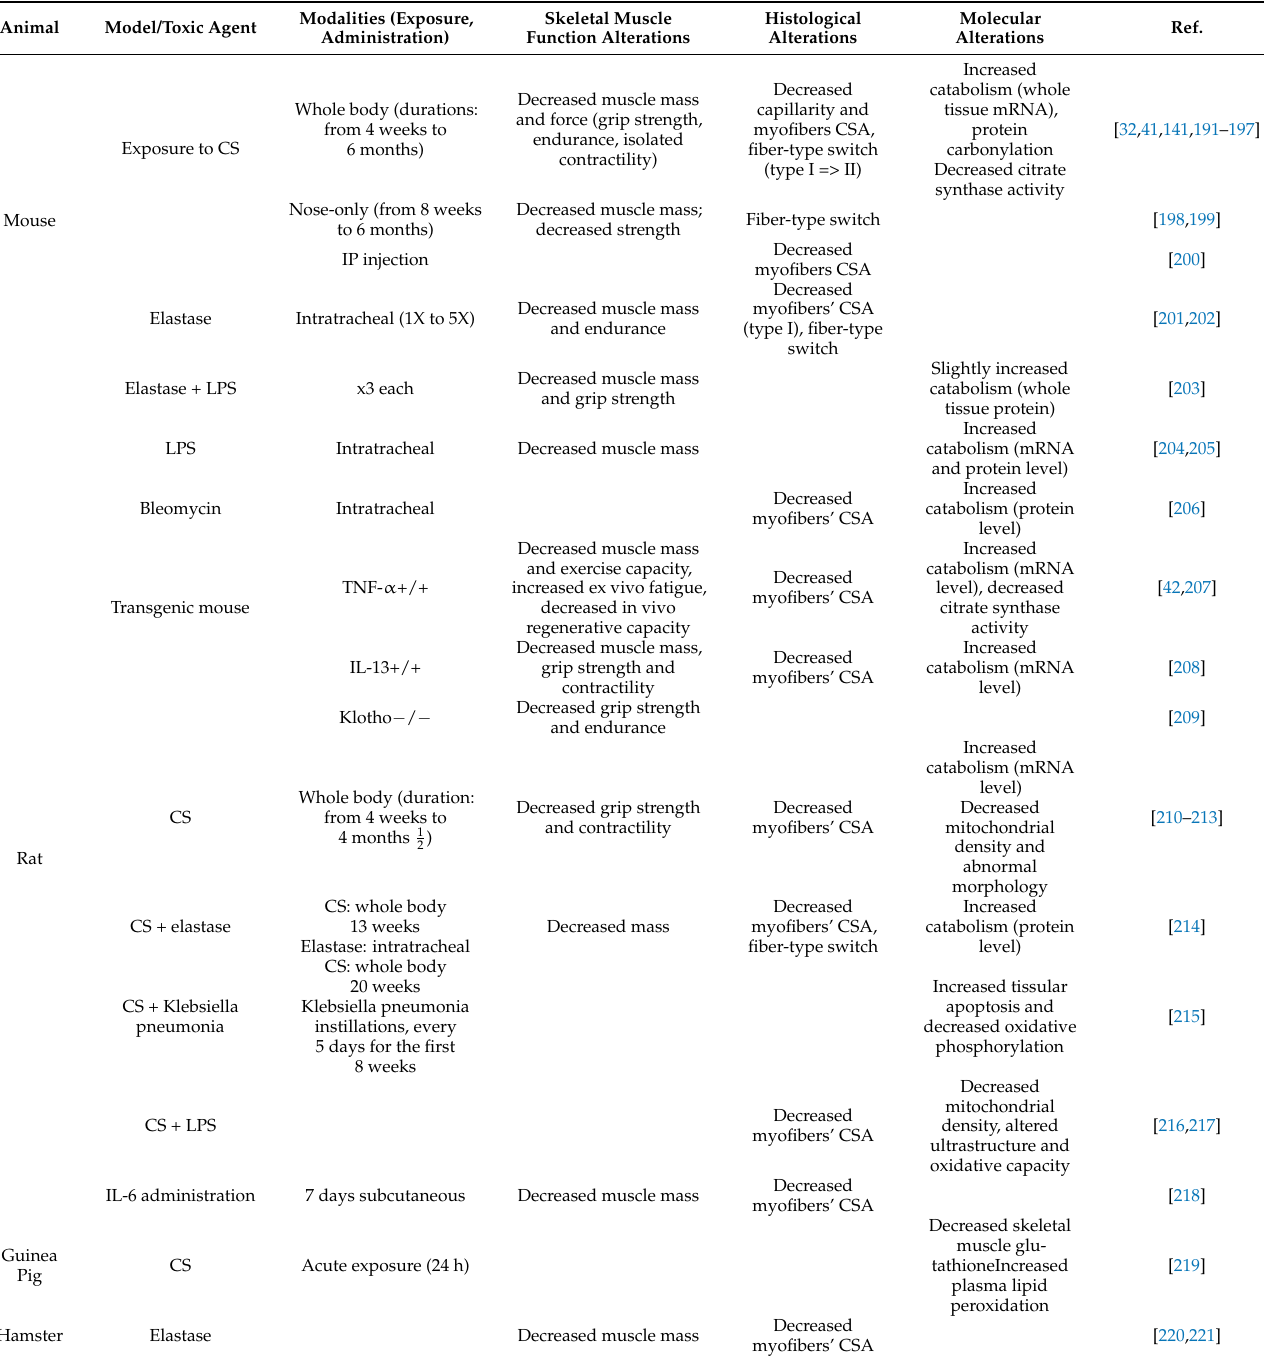
Table 1. Characterization of locomotor skeletal muscle dysfunction in COPD rodent